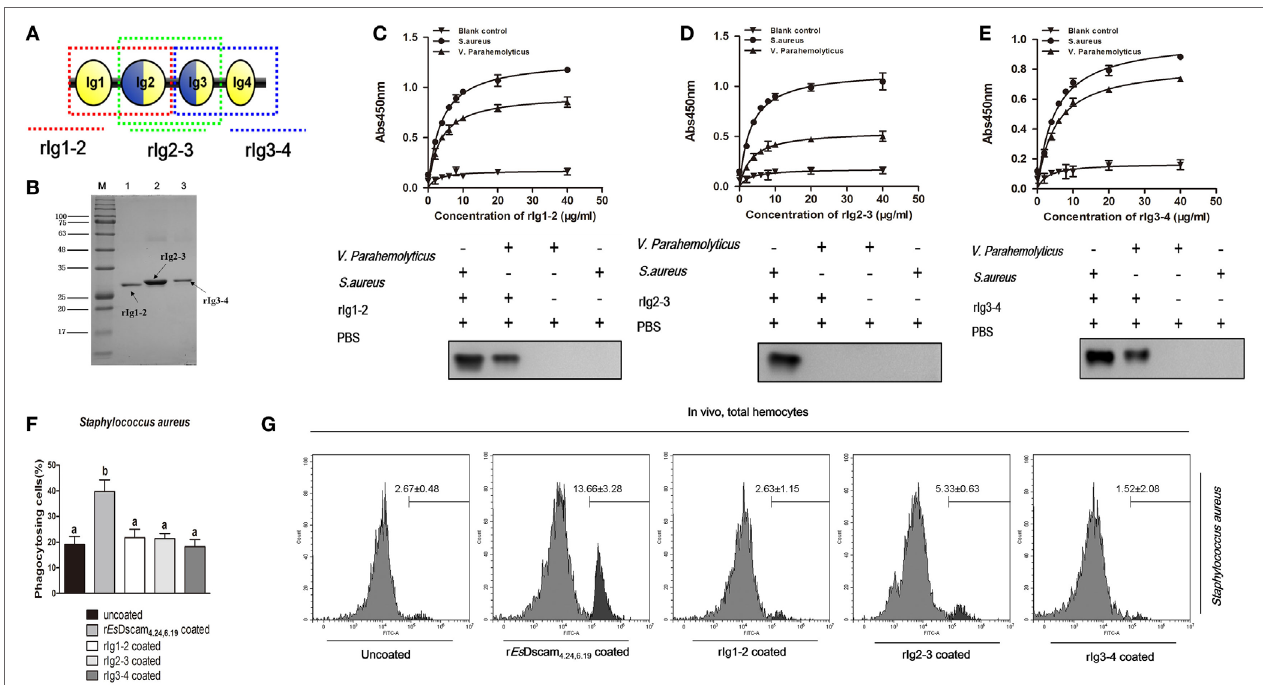
FigUre 6 | Truncated soluble Es Dscam exhibit variation in bacteria-binding ability and loss of the capacity to promote phagocytosis. (a) Schematic diagram of truncated r Es Dscam 4.24,6.19 . The red, green, and blue dotted lines represents the rIg1–2, rIg2–3, and rIg3–4 proteins, respectively. The three domains were expressed in vitro using a prokaryotic expression system (results of the construction, expression, and purification of the recombinant isoforms are shown in Figure S4 in Supplementary Material). (B) Recombinant truncated soluble Es Dscam proteins were analyzed by SDS-PAGE. Three proteins were expressed from the pET-28a ( + ) vector in Escherichia coli Rosetta (DE) cells and purified by affinity chromatography. (c–e) Quantitative binding of truncated r Es Dscam proteins with bacteria. The binding activity between truncated r Es Dscam proteins and bacteria were detected by ELISA using anti-His-tag antibodies. PBS incubated with microorganisms was used as the control. Absorbance data ( upper panel ) represent the mean ± SD of three independent experiments. Western data ( lower panel ) are representative of two independent repeats. (F) Truncated Es Dscam has slight effect on phagocytosis of bacteria in vitro . Each recombinant protein was incubated with FITC-labeled Staphylococcus aureus and then used to stimulate hemocyte, with r Es Dscam 4.24,6.19 as positive control. Three independent repeats were performed, and results are expressed as the mean ± SD. Data were analyzed by one-way ANOVA and the letters (a, b) presented significant differences ( p < 0.05). (g) Truncated Es Dscam has slight effect on phagocytosis of bacteria in vivo . S. aureus was heat-inactivated and labeled with FITC before coating with each r Es Dscam protein. The bacteria were then injected into the hemolymph of crab and hemocytes were collected 1 h later for flow cytometry analysis, with uncoated bacteria as control. A total 10,000 hemocytes were counted for each sample. Three independent repeats were performed, and results are expressed as the mean ±